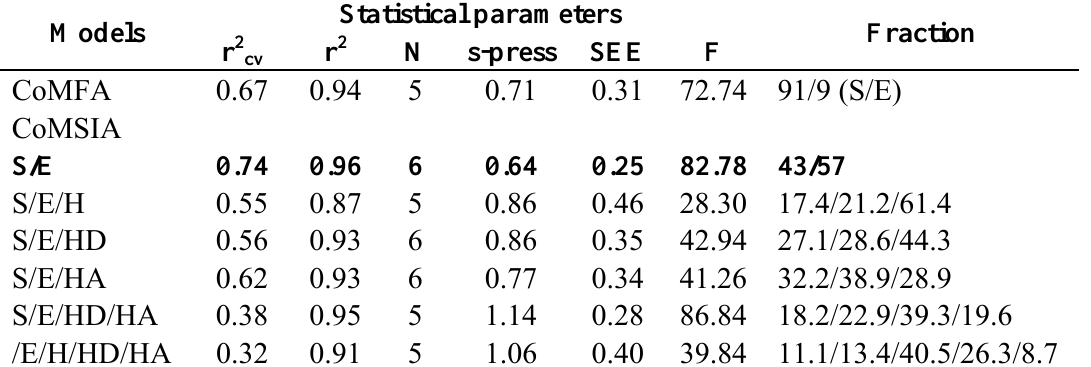
Table 4. The statistical parameters of the CoMFA and CoMSIA